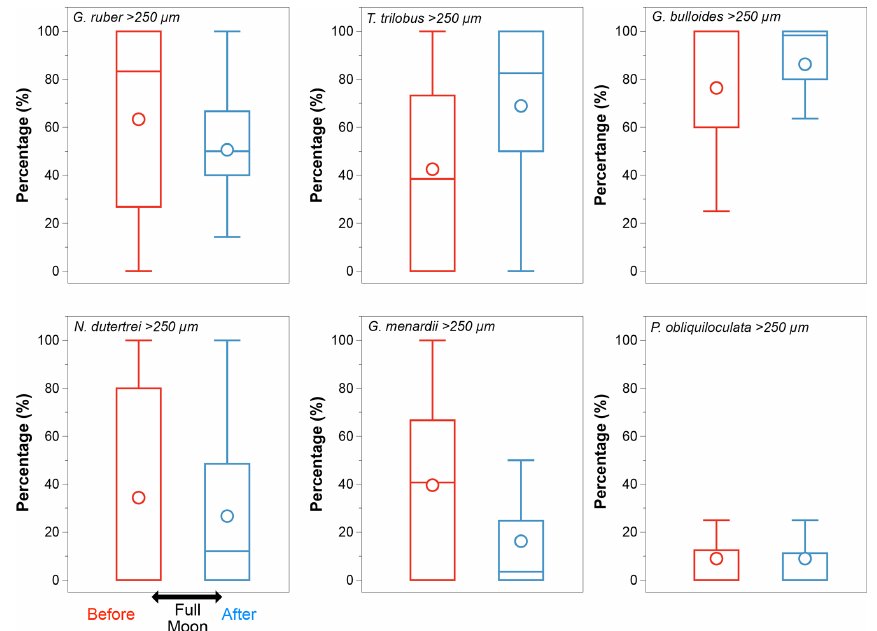
Figure A2. Size class distribution ( > 250µm) of the six selected species. Globigerinoides ruber , N. dutertrei , and G. menardii show a reduction in the proportion of the size class > 250µm after a full moon (blue). The large difference in their median values points to an over-representation of the large size classes suggesting synchronized reproduction; P. obliquiloculata shows no differences in the size class distribution before (red) and after (blue) the full moon; Globigerina bulloides and T. trilobus show an increase in the proportion of larger organisms after the full moon. Median values are shown by bars, and circles represent mean